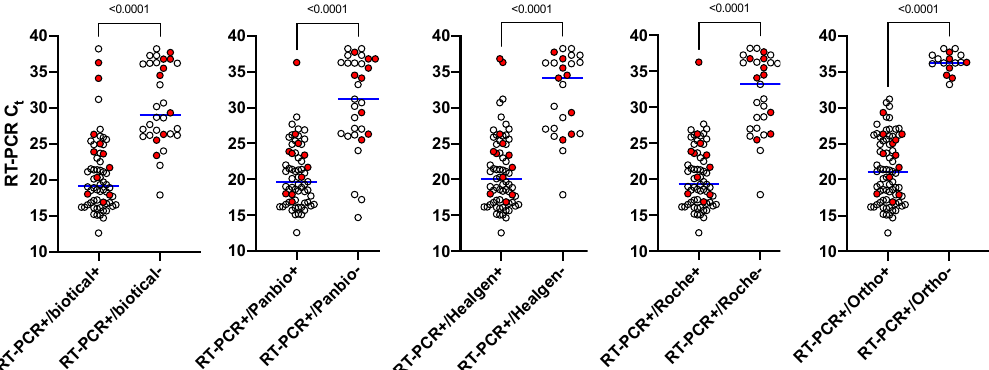
Figure 1. Graphical representation of positive and negative antigen results according to RT-PCR Ct values. A significant difference in the Ct value is observed between the positive and negative tests for each antigen method. Importantly, only the automated antigen shows no overlap between Ct values obtained for positive and negative samples. Samples from asymptomatic subjects are highlighted in